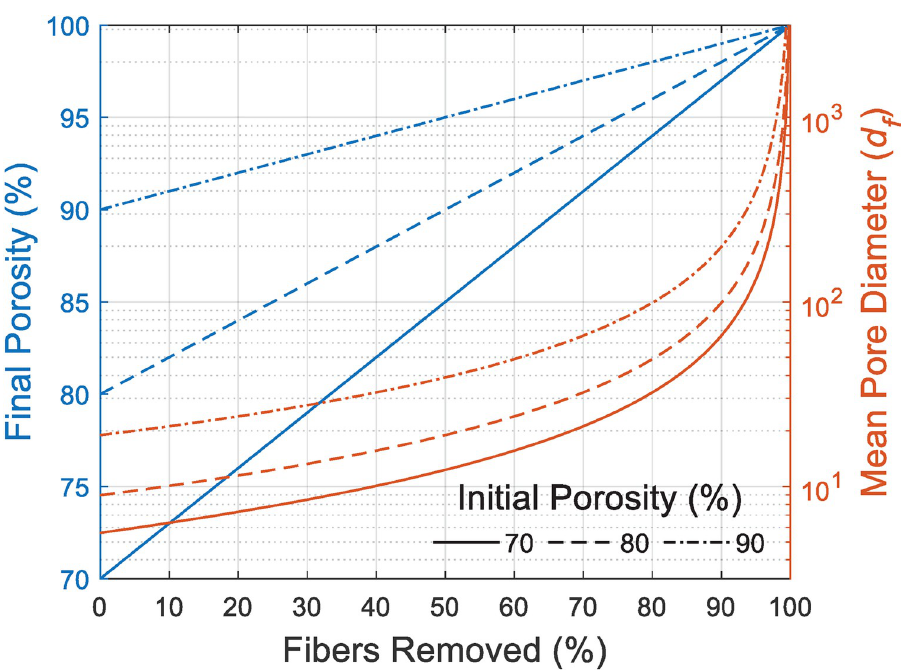
Fig 10. Projections of final porosity (left-hand y-axis, straight lines) and pore size (right-hand y-axis, predicted by Eq (3), curved lines) versus removal of sacrificial fiber from initial scaffolds having the porosities shown in the legend. The pore size reported is rendered dimensionless as ratio over fiber